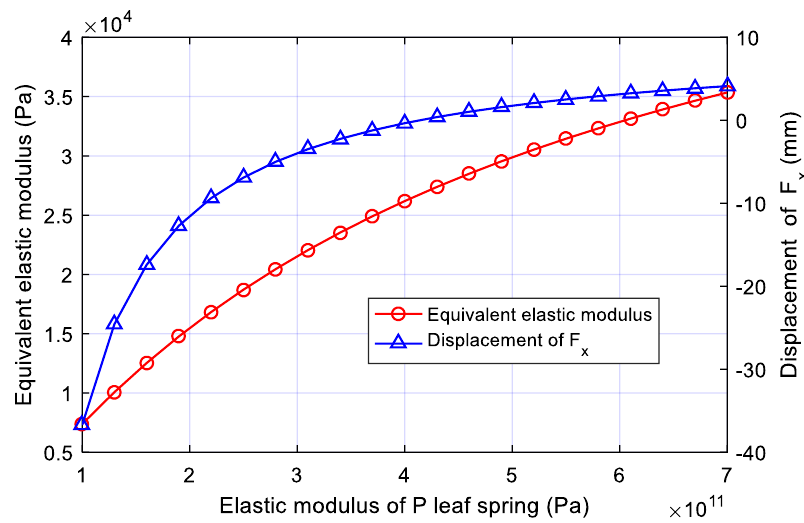
Figure 4. Variation of equivalent elastic modulus 𝐸̅ and the x -direction displacement of the bionic leg ( F 𝑥 ) with Ep, Eq = 197 GPa, initial length 800.9 mm, and the compressive force is 300 N.